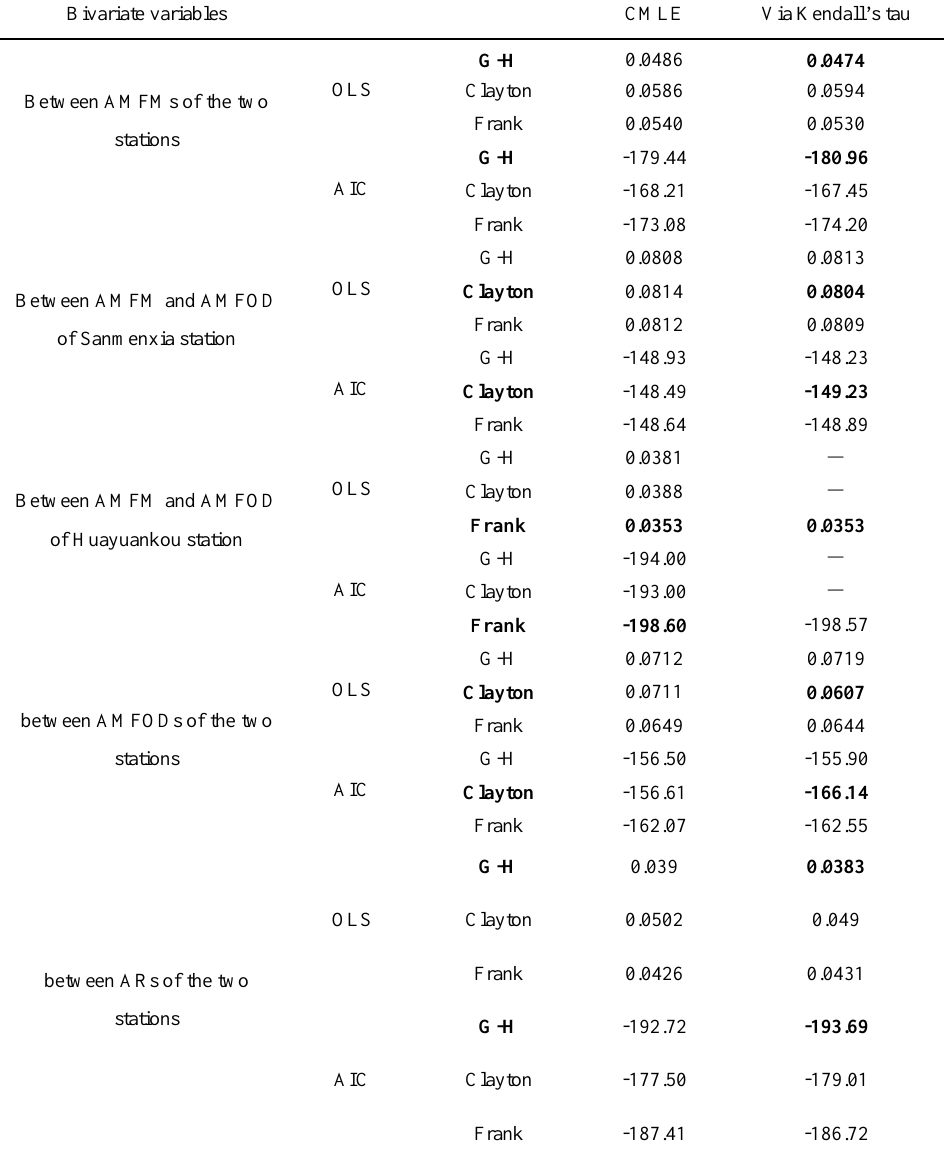
Table 4 GOF results of different  and